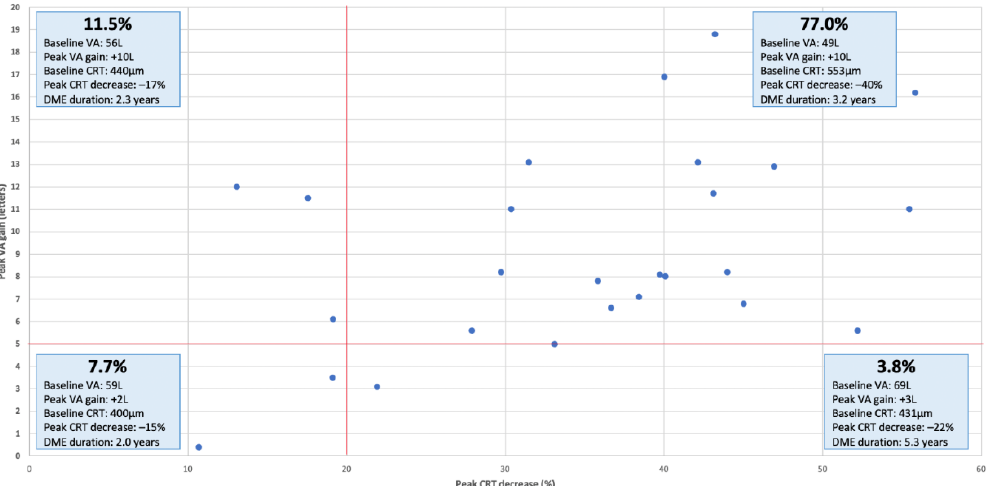
Figure 4. Peak visual acuity gain as a function of peak central retinal thickness decrease in real-world studies evaluating the efficacy of the fluocinolone acetonide implant for diabetic macular edema. Mean follow-up was 20.2 months ( n = 18 studies). Top left, functional responders; top right, anatomical and functional responders; bottom left, anatomical and functional non-responders; bottom right, anatomical responders.